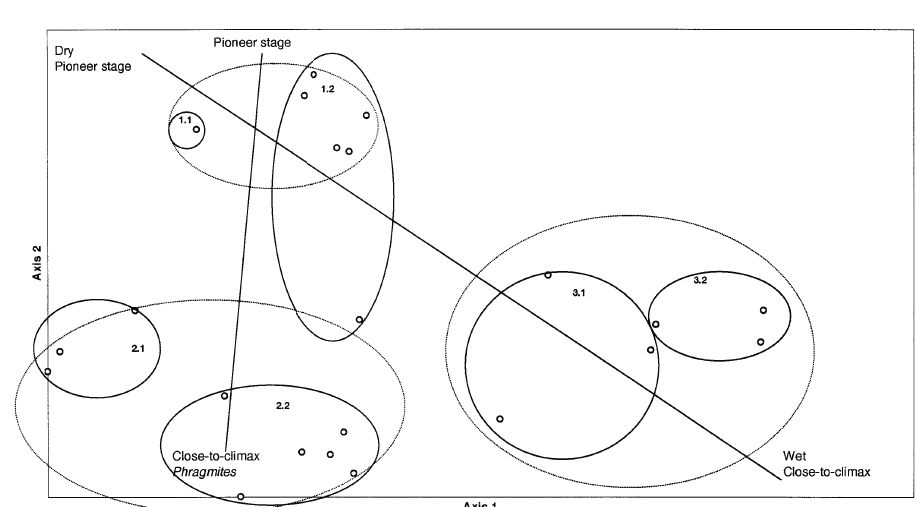
Fig. 2. Scatter diagram of a DECORANA ordination illustrating the difference between the communities along an environmental gradient using the 2001 dataset. Axis 1 was plotted against Axis